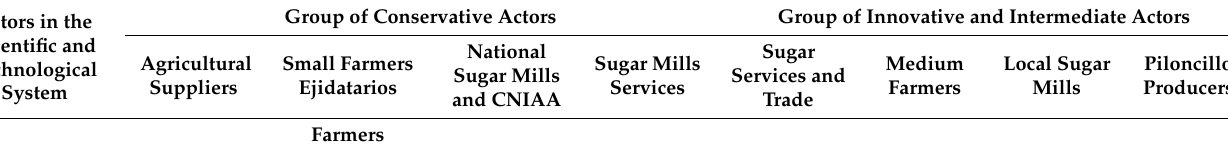
Table 3. Relations of R&D system with the conservative, intermediate and innovative network actors.